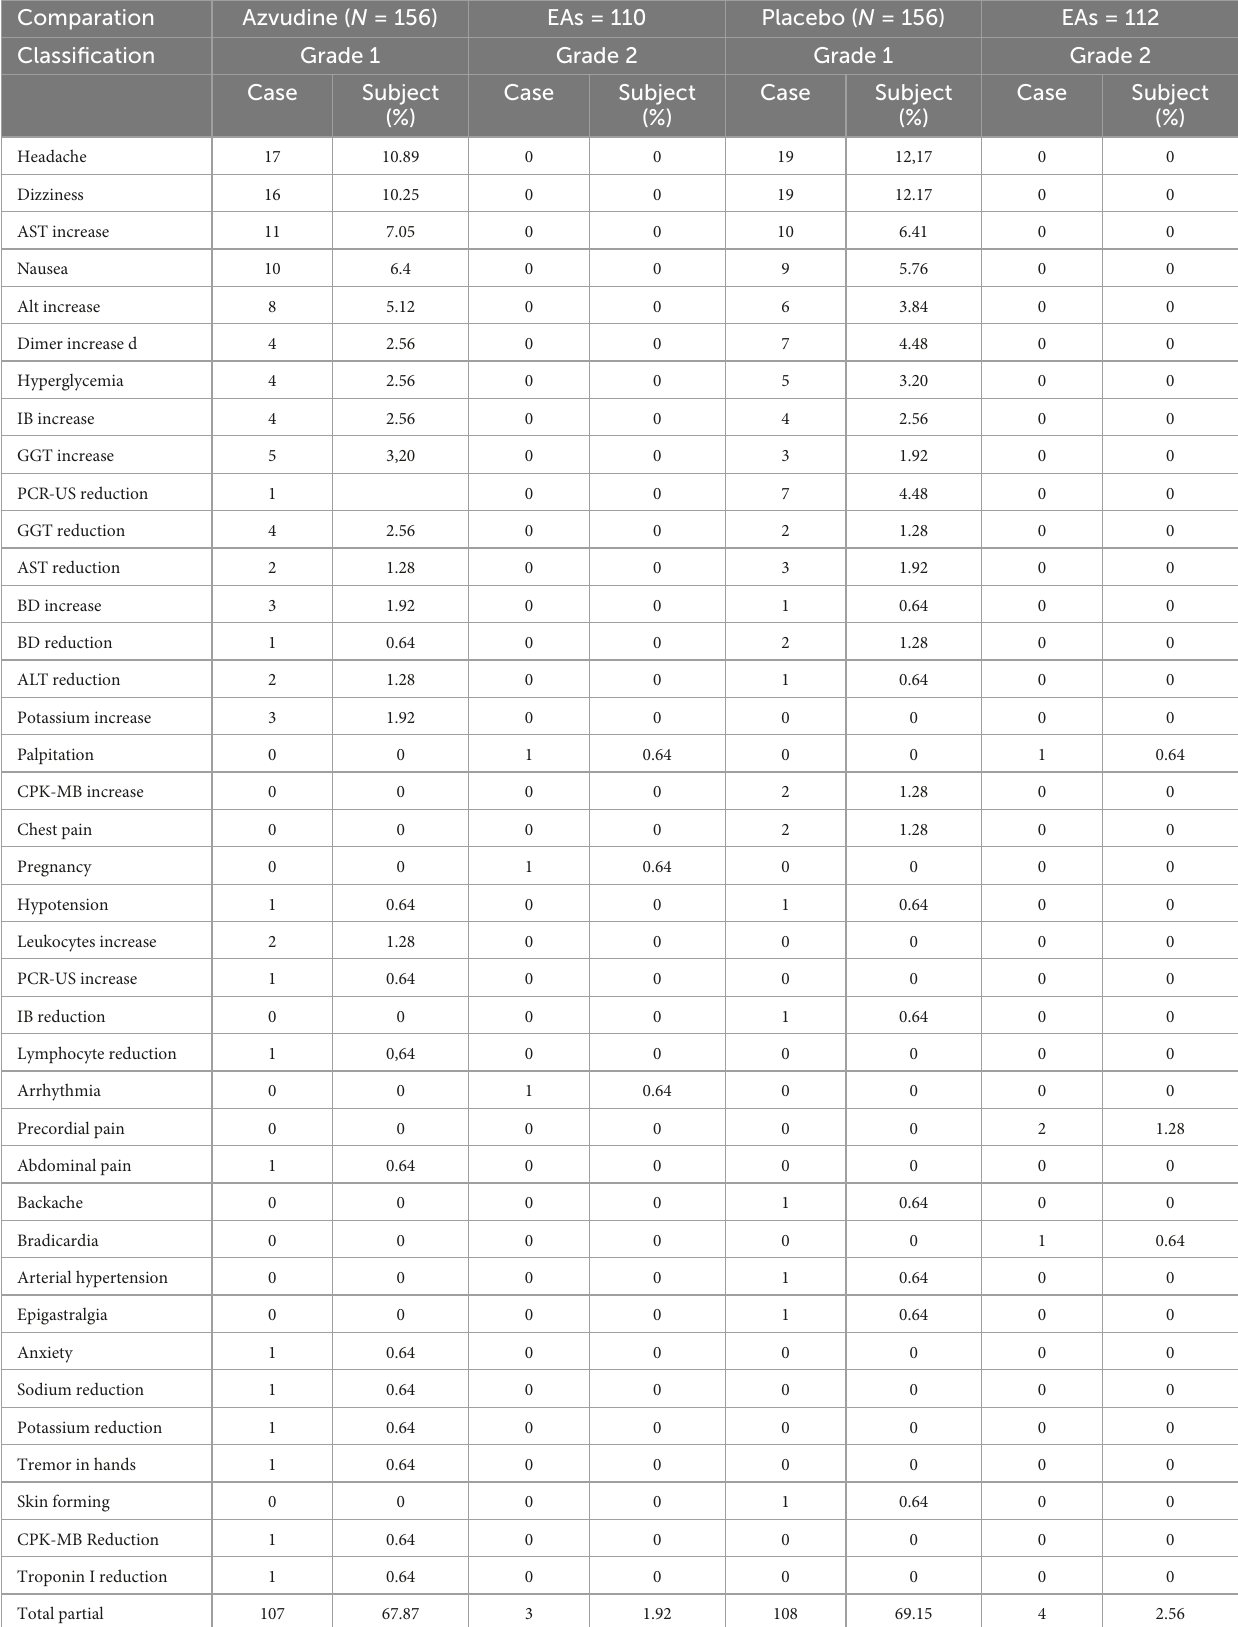
TABLE 5 Consolidated report of adverse